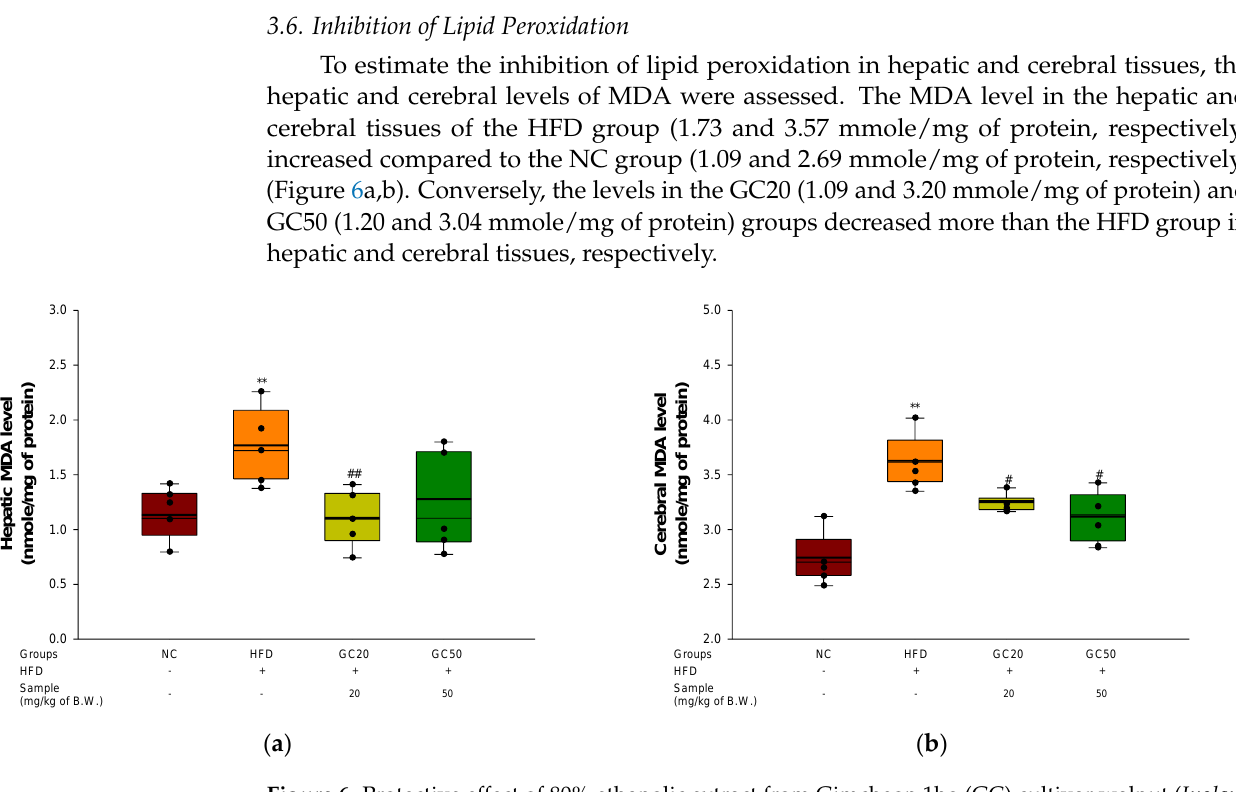
Figure 6. Protective effect of 80% ethanolic extract from Gimcheon 1ho (GC) cultivar walnut ( Juglans regia ) on malondial- dehyde (MDA) contents in HFD-induced mice biochemical changes related with antioxidant system: ( a ) hepatic MDA level; ( b ) cerebral MDA level Results shown are mean ± SD ( n = 5). Data are statistically represented with * = significantly different from the NC group, and # = significantly different from PM group; * and # p < 0.05, ** and ## p < 0.01. Bold line indicates mean.